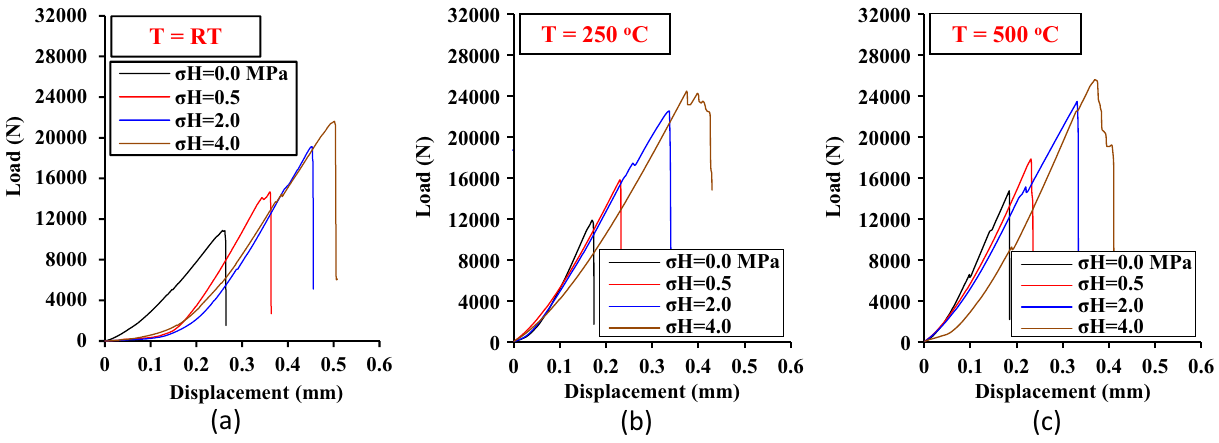
Figure 8. Displacement-load curves of the tested SCC samples at three temperatures of ( a ) RT, ( b ) 250 and ( c ) 500